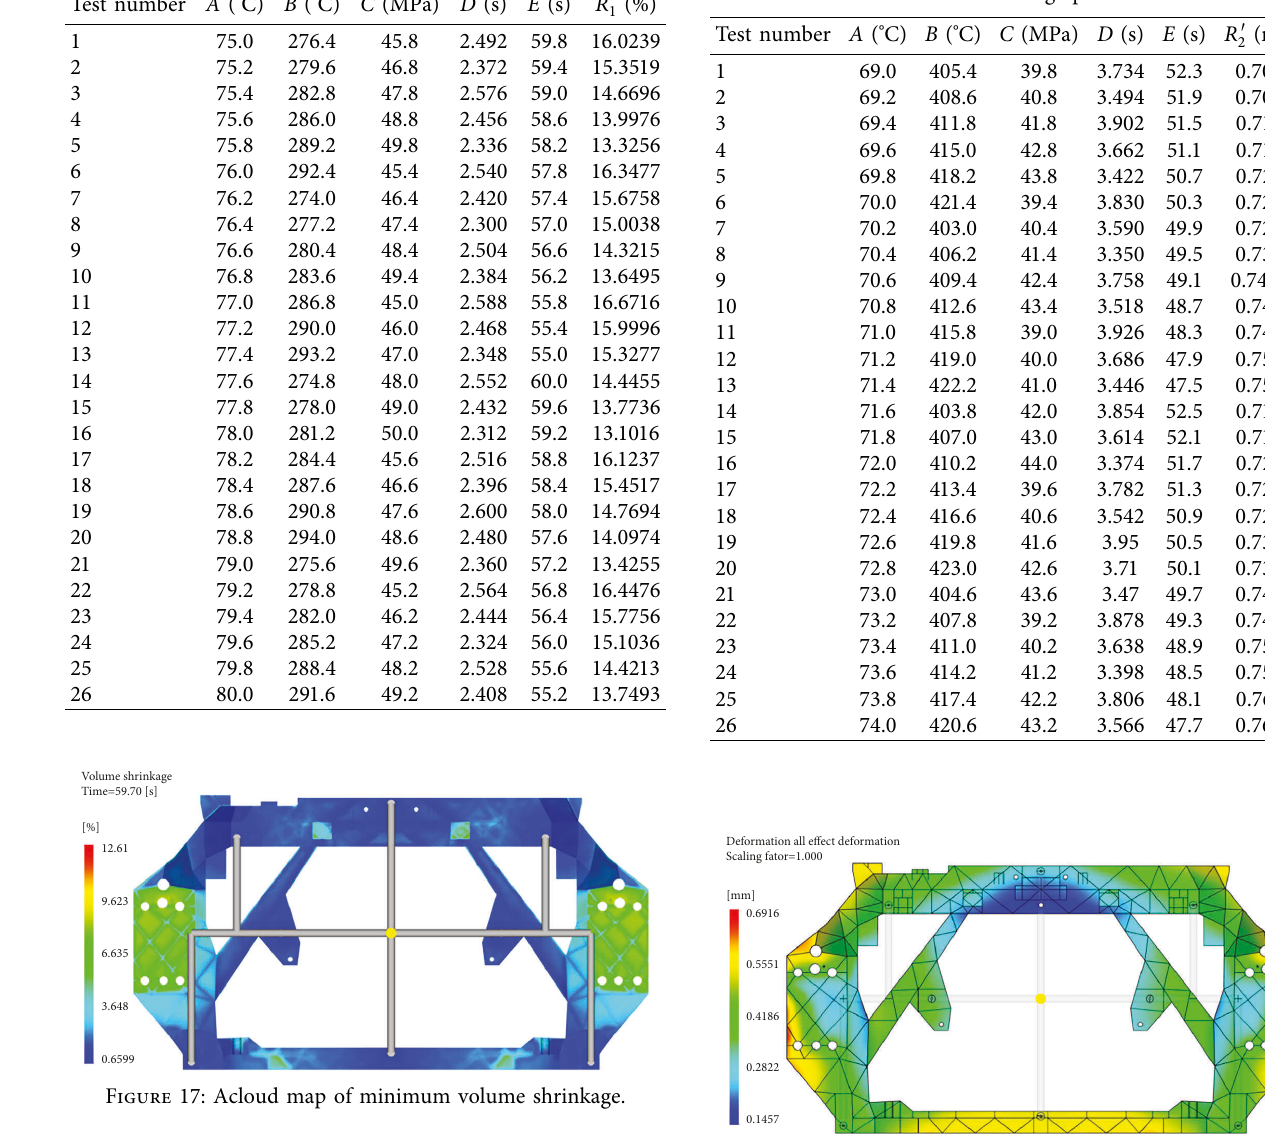
Table 14: Volume shrinkage prediction table.